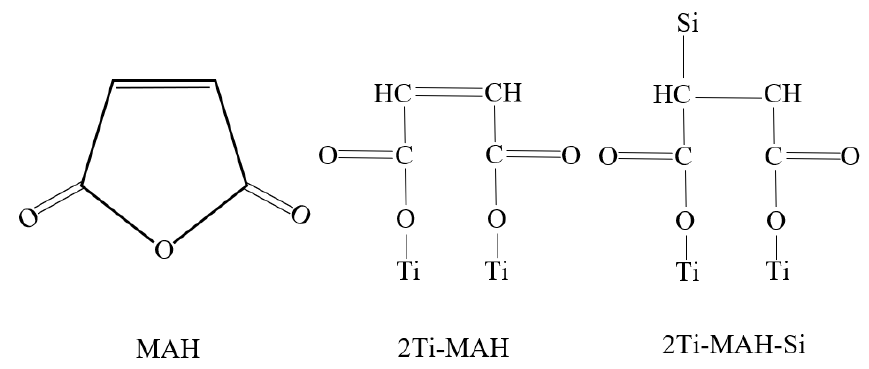
Figure 6. Proposed structure arrangement of MAH, 2Ti-MAH, and 2Ti-MAH-Si.